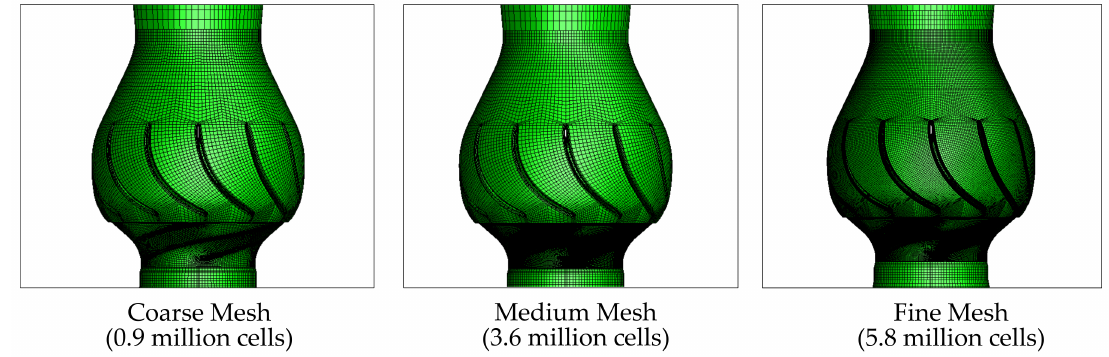
Figure 3. The mesh used for the grid independence study.